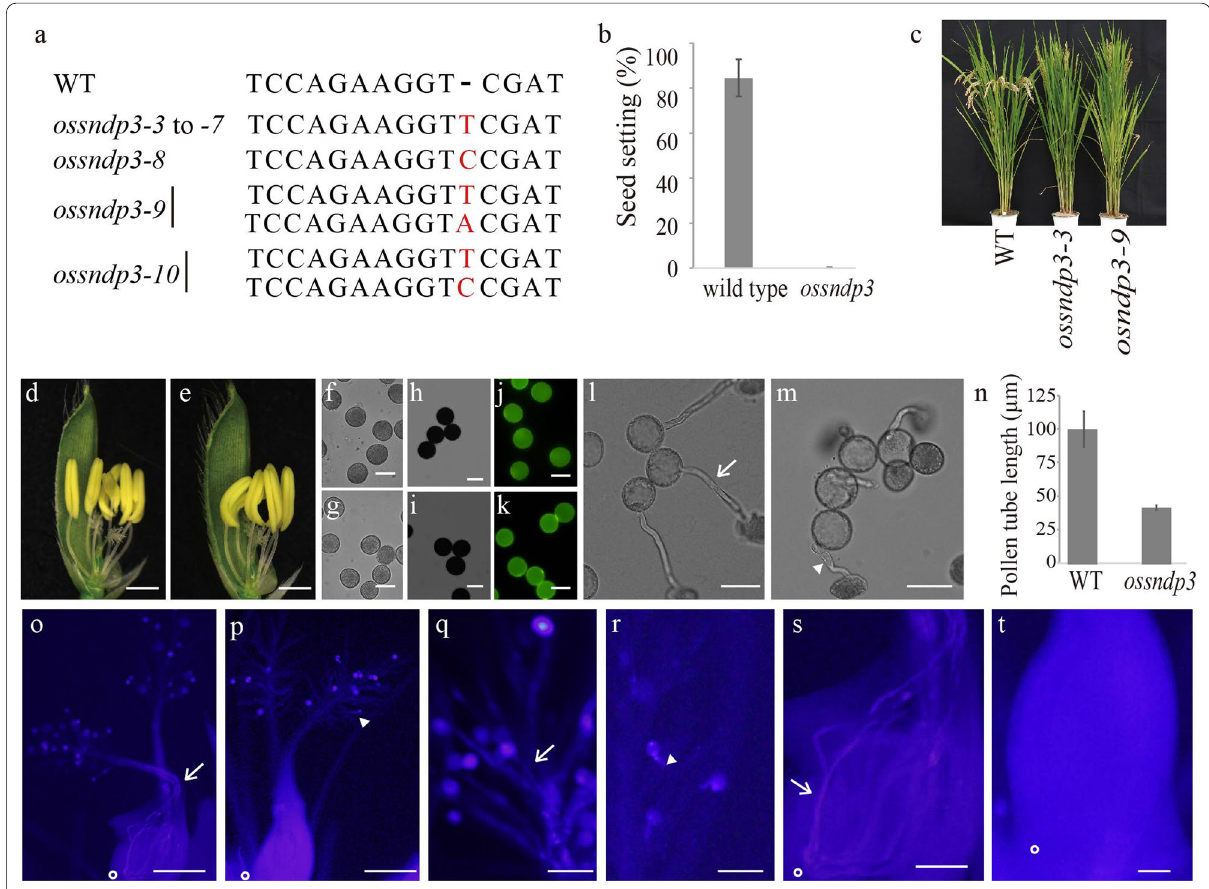
Fig. 3 The mutant phenotype of OsSNDP3 . a Sequencing analysis of the target sites of CRISPR/Cas9 on the genomic regions of OsSNDP3 . Red characters indicate mutated sequences. b Fertilities of nine panicles from wild type and ossndp3 . Each three panicles used from ossndp3-3 , ossndp3-4 and ossndp3- 5. c Picture of wild type, ossndp3-3 and ossndp3-9 at ripening stage. Flower structure ( d and e ), pollen in PBS ( f and g ) and pollen stained by Lugol’s iodine ( h and i ), and Auramine O ( j and k ) from the WT ( d , f , h, and j ) and ossndp3-3 ( e , g , i, and k ) . In vitro pollen germination of wide type ( l ) and ossndp3-3 ( m ). Pictures were taken 30 min after germination on solid germination media. Arrow represented long pollen tube from wild type and triangle indicated short pollen tube from ossndp3-3 . n pollen tube length from wild type and ossndp3-3 . Values are means ( SE) of pollen tube lengths (n > 25 pollen tubes). In vivo pollen germination stained by aniline blue ( o – t ). The pollens on stigma germinate ± through the style and enter the micropyle (open circle) in wild type ( o , q, and s ). The short pollen tube (triangle) stayed in the stigma of ossndp3-3 ( p , r, and t ). Bars 1 mm ( d and e ), 50 µm ( f – m ), 500 µm ( o and p ), and 100 µm ( q – t =